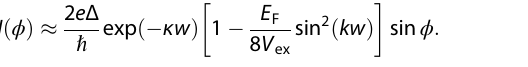
p = _ with 2 m (cid:6) ð V ex þ E F Þ